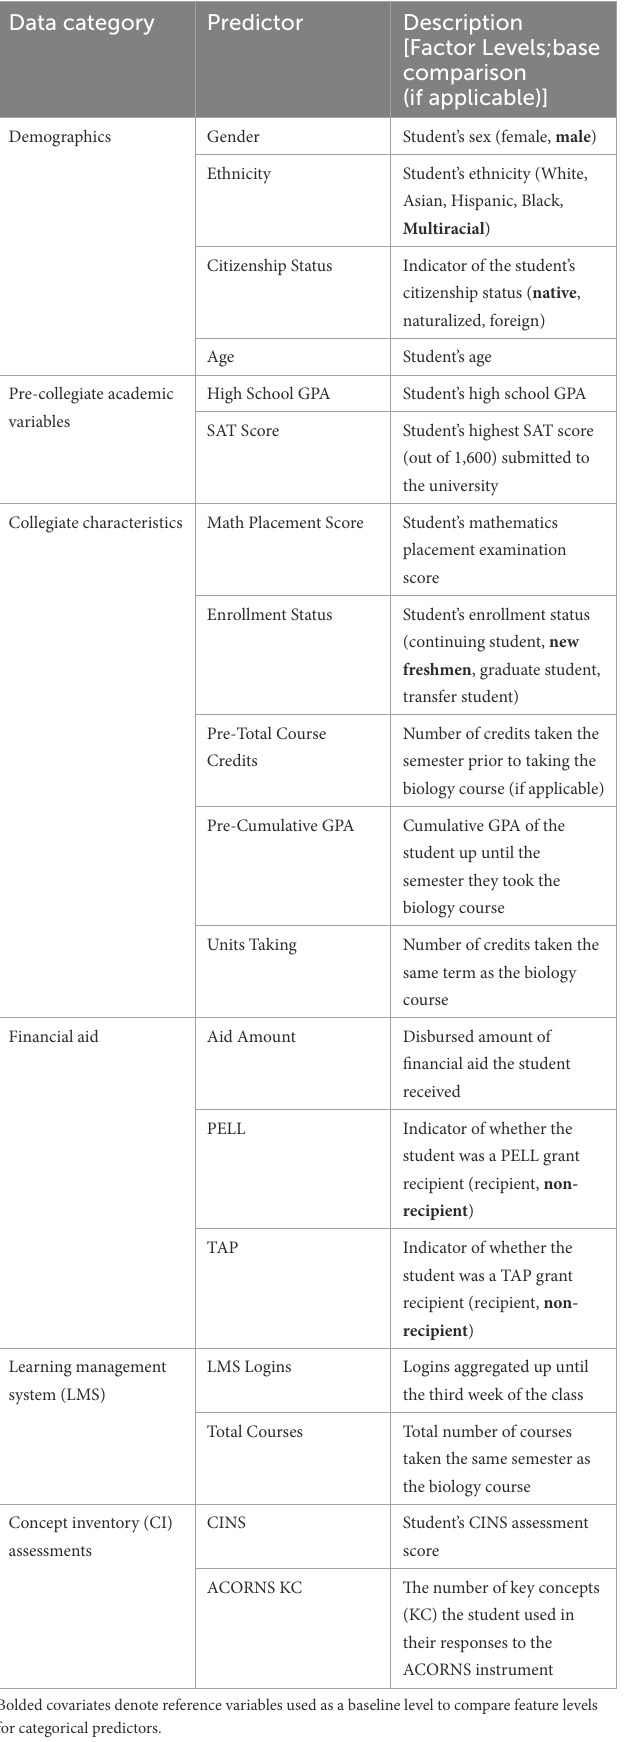
TABLE 2 Description of predictor variables by data